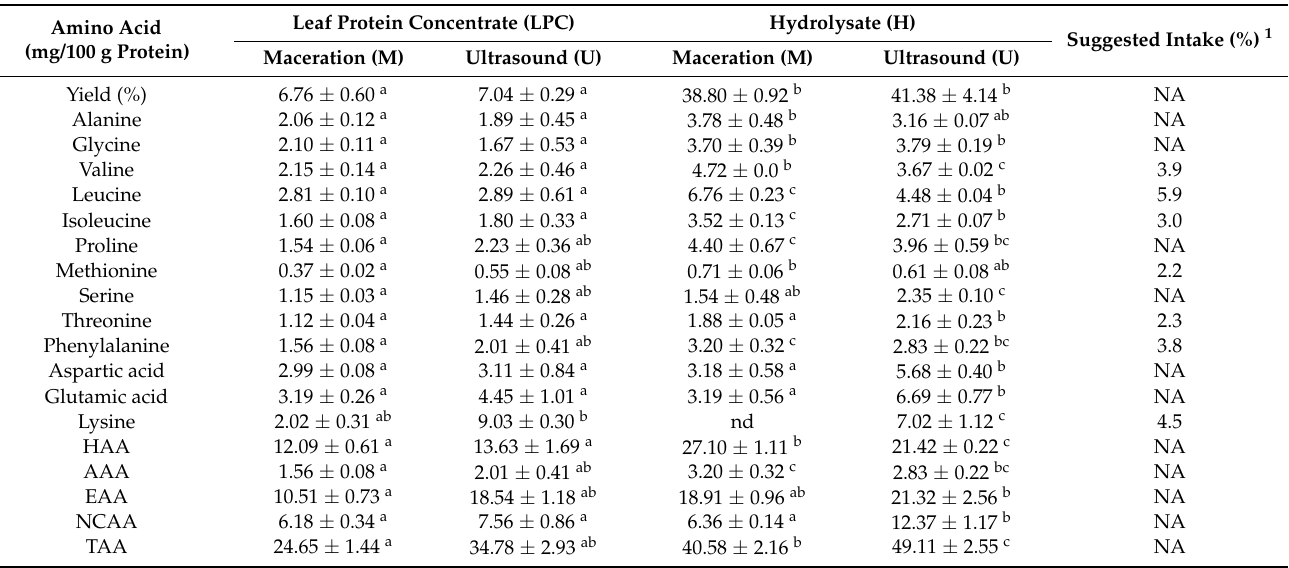
Table 1. Amino acid composition and yield of leaf protein concentrates obtained by maceration and ultrasound and their